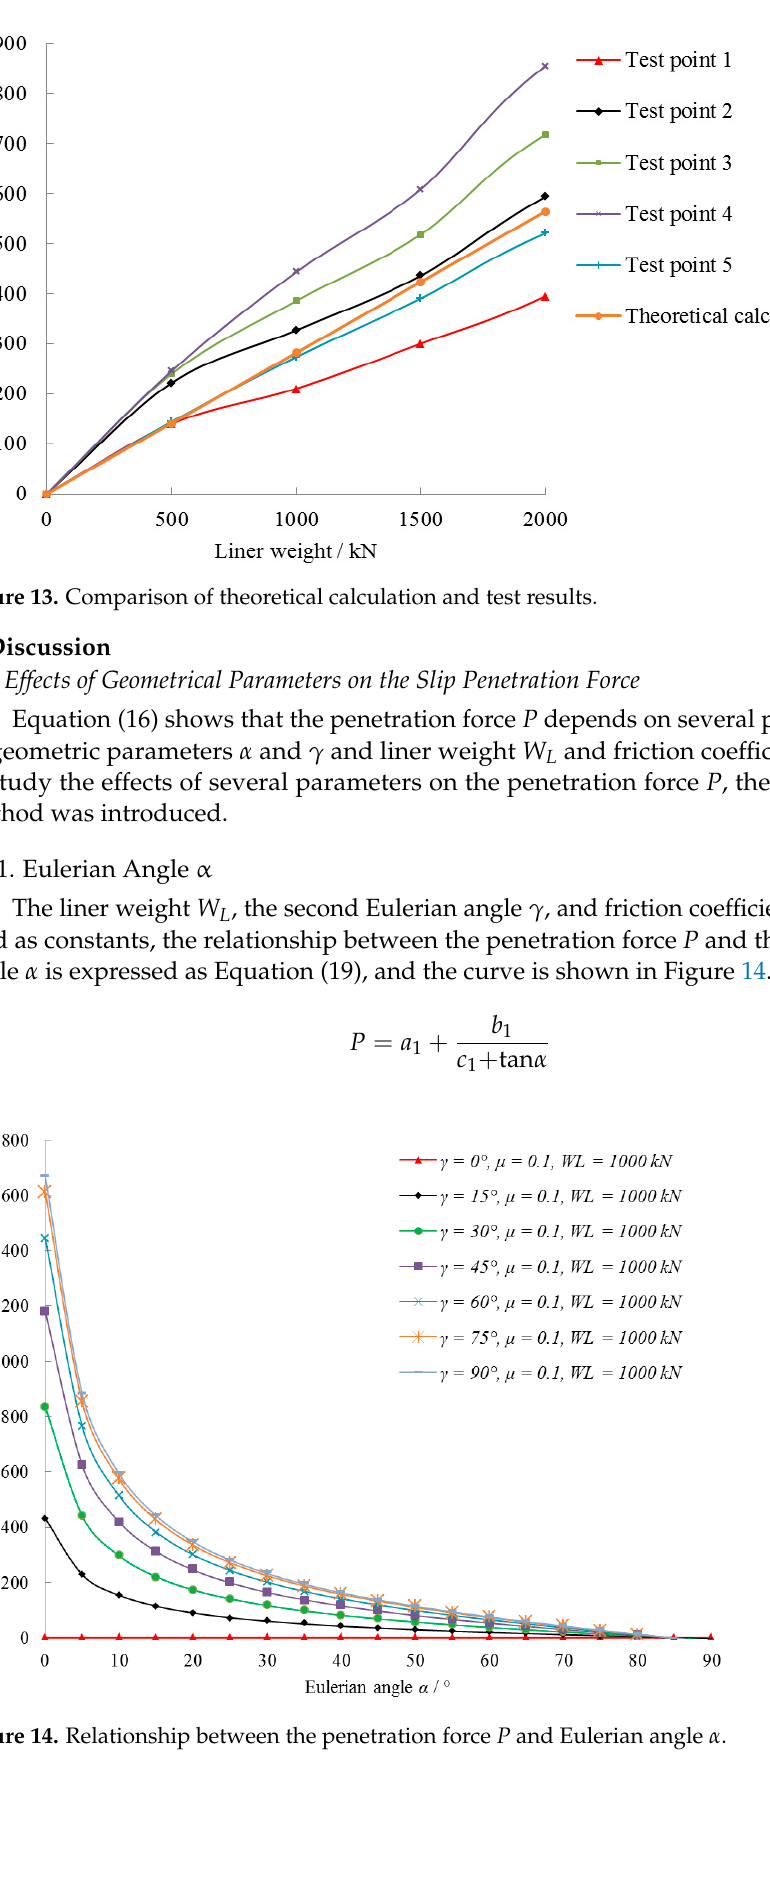
(20) Figure 15. Relationship between the penetration force P and Eulerian angle γ .